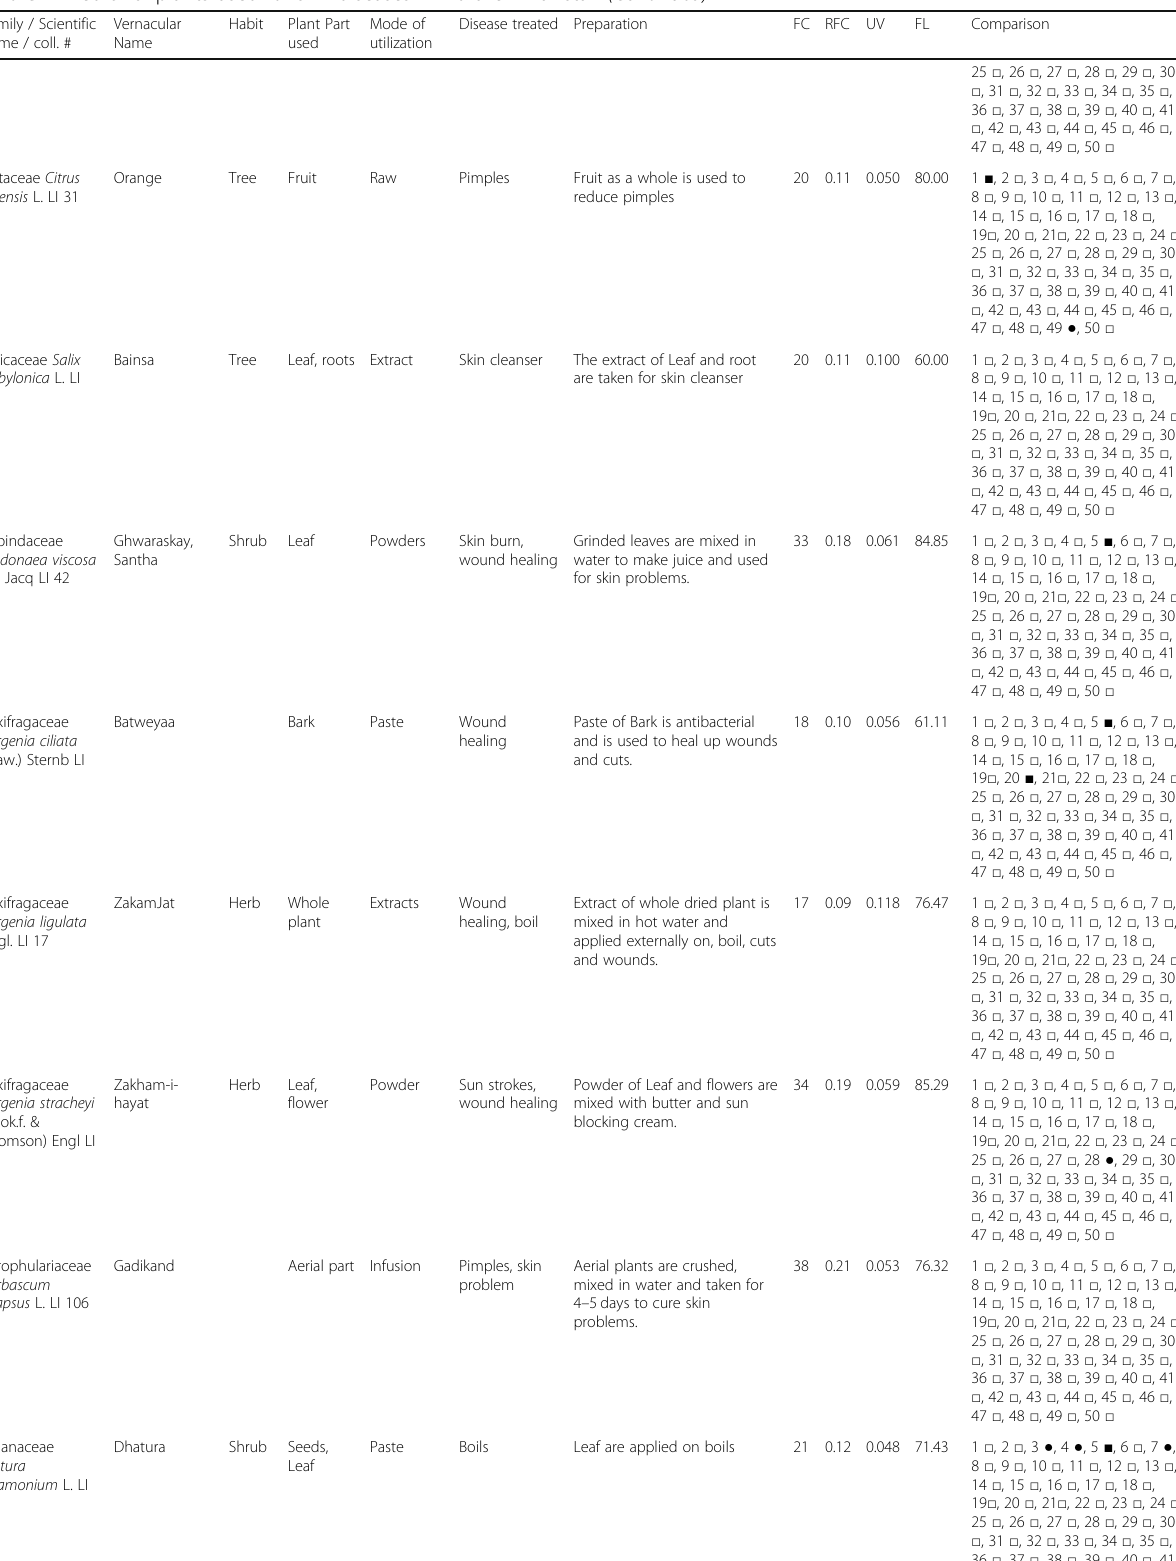
Table 2 Medicinal plants used for skin diseases in Northern Pakistan (Continued) Family / Scientific name / coll.